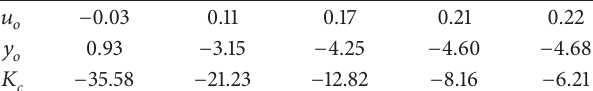
Table 2: Operating points for 5